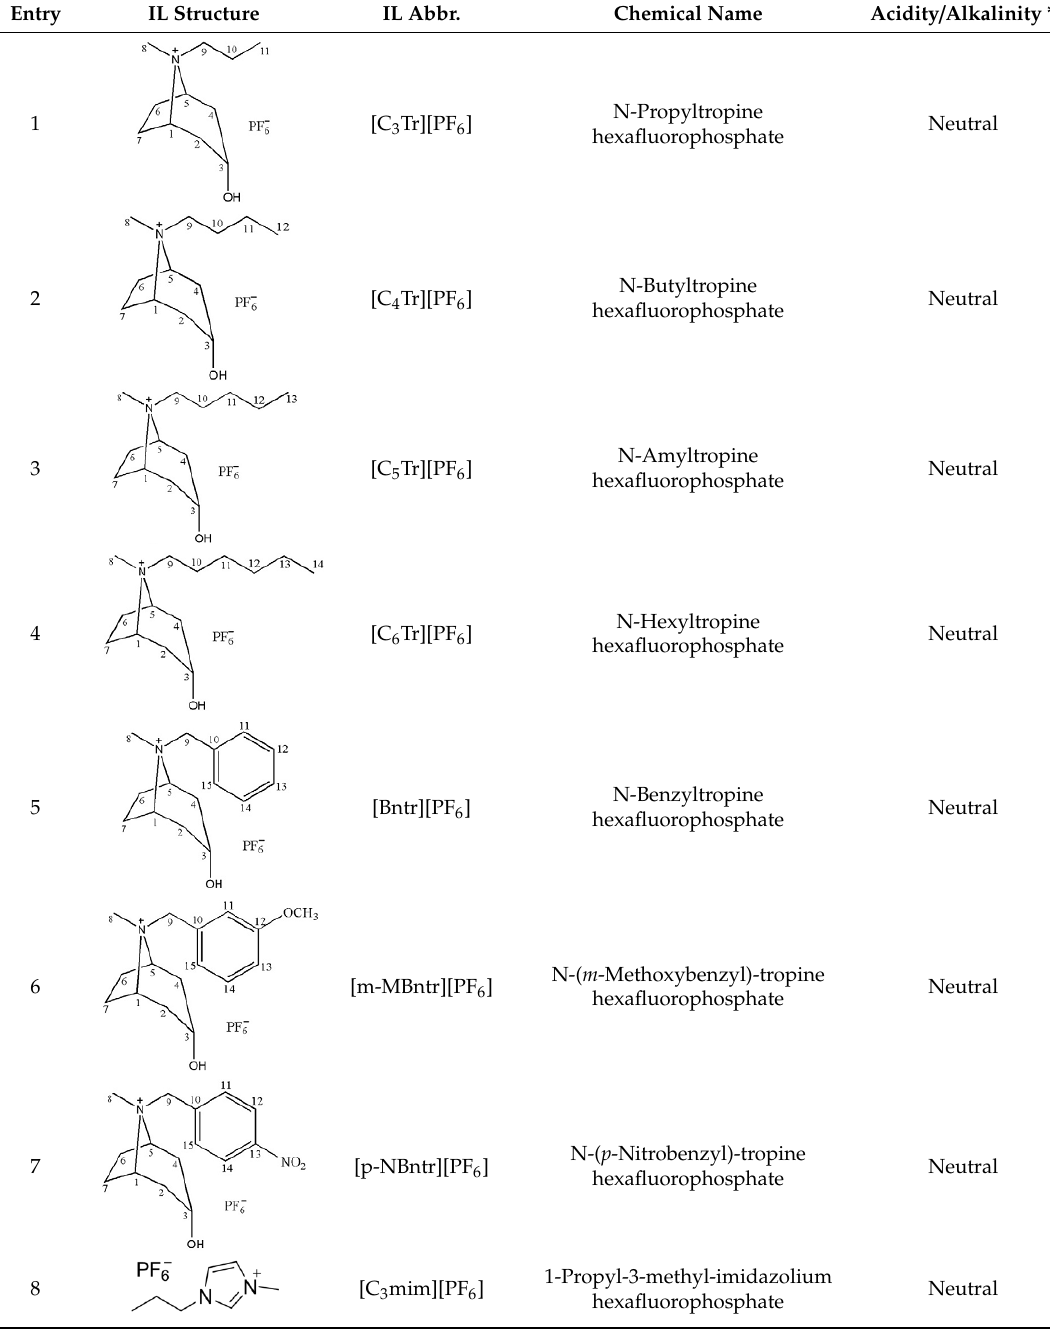
Table 1. Structures, chemical names and acid-base properties of the eight studied ILs.